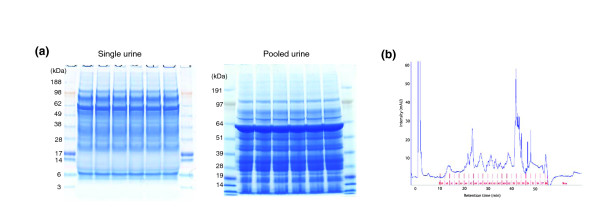
Urinary protein separation by one-dimensional SDS gel and reverse-phase HPLC. (a) 150 μg urinary protein (25 μg/lane) from single sample and pooled sample were applied on a 4-12% Bis-Tris gel. Gel was stained by colloidal Coomassie and cut into 14 pieces (in-gel 1 set) or 10 pieces (in-gel 2 set) for single urine sample, and cut into 10 pieces for pooled urine sample. (b) 250 μg of urinary protein was applied to Vivapure Anti-HSA Kit to deplete serum albumin. The albumin-depleted protein mixture was dissolved in 6 mol/l urea and 1.0% acetic acid solution, and separated on mRP-C18 High-Recovery protein column at 80°C using linear multi-segment gradient, as described in the Materials and Methods section. HPLC, high-performance liquid chromatography; SDS, sodium dodecyl sulfate.